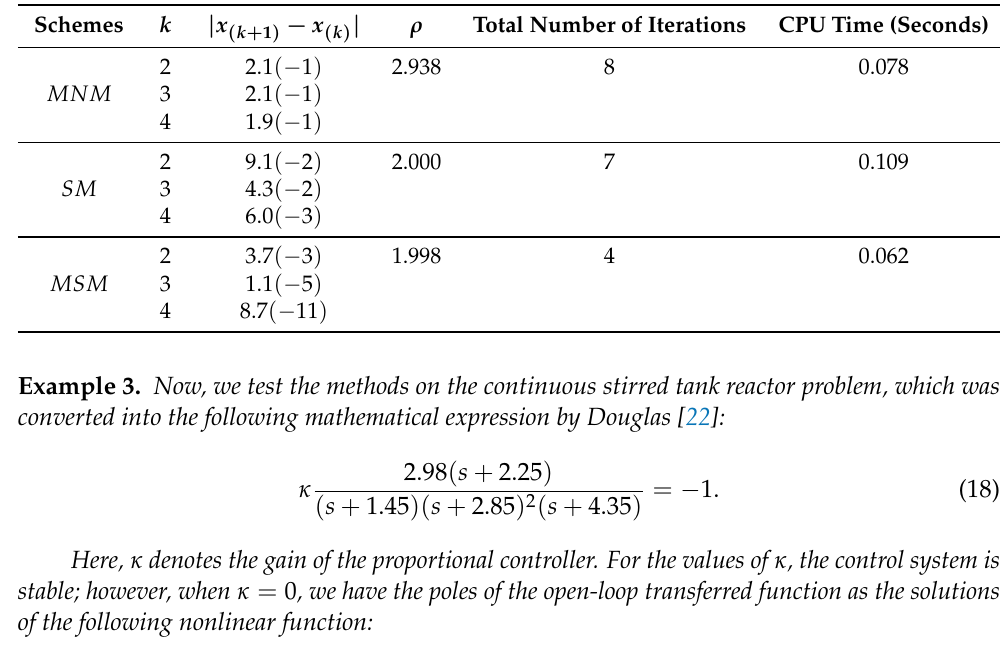
Table 2. Convergence behavior of the methods MNM , SM , and MSM at approximation x 0 =